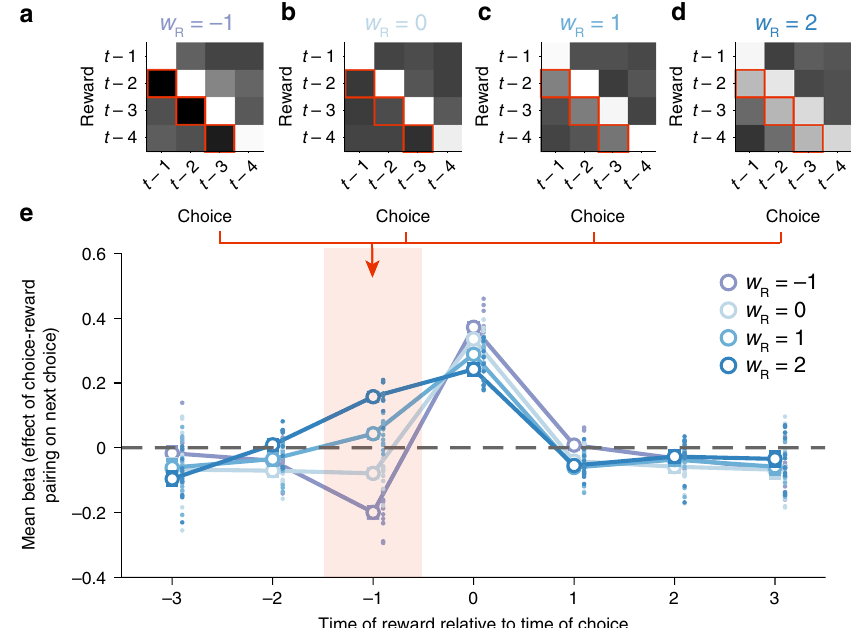
Fig. 4 Model simulations show that forward spread of effect can emerge from the GRS. a – d Choice simulations using different levels of w R ( − 1, 0, 1, 2, respectively) are analyzed with a GLM that estimates the effect of each possible choice-reward-pair going four trials back on subsequent choices. Lighter colors indicate more positive beta weights, i.e. subsequent choice probability is increased by reward delivered for the respective conjunction. For example, when w R is set to zero in panel b , the bright white diagonal indicates that the next choice the agent takes is in fl uenced by the conjunction of choice and reward on the previous trial ( t -1), the trial before that ( t -2) and so on. However, as w R increases ( c , d ), the precise history of choice-reward conjunction has less effect and conjunctions between choices made on one trial and reward occurrences on other trials become more likely to in fl uence the next choice that is taken (lighter colors at lower left in c and d ). e Effects of rewards delivered at various time points relative to time point 0 on the probability of repeating the choice made at time point zero. Effects are derived from averaging beta weights shown in panels a – d along the diagonal with different offsets. The area shaded in red corresponds to the mean effects along the red squares in panels a – d and indicates that rewards have contrasting ( w R < 0) or facilitating effects on repeating subsequent choices ( w R > 0) depending on w R . (error bars are ±SEM around the mean across simulated monkey data sets, n = 12).